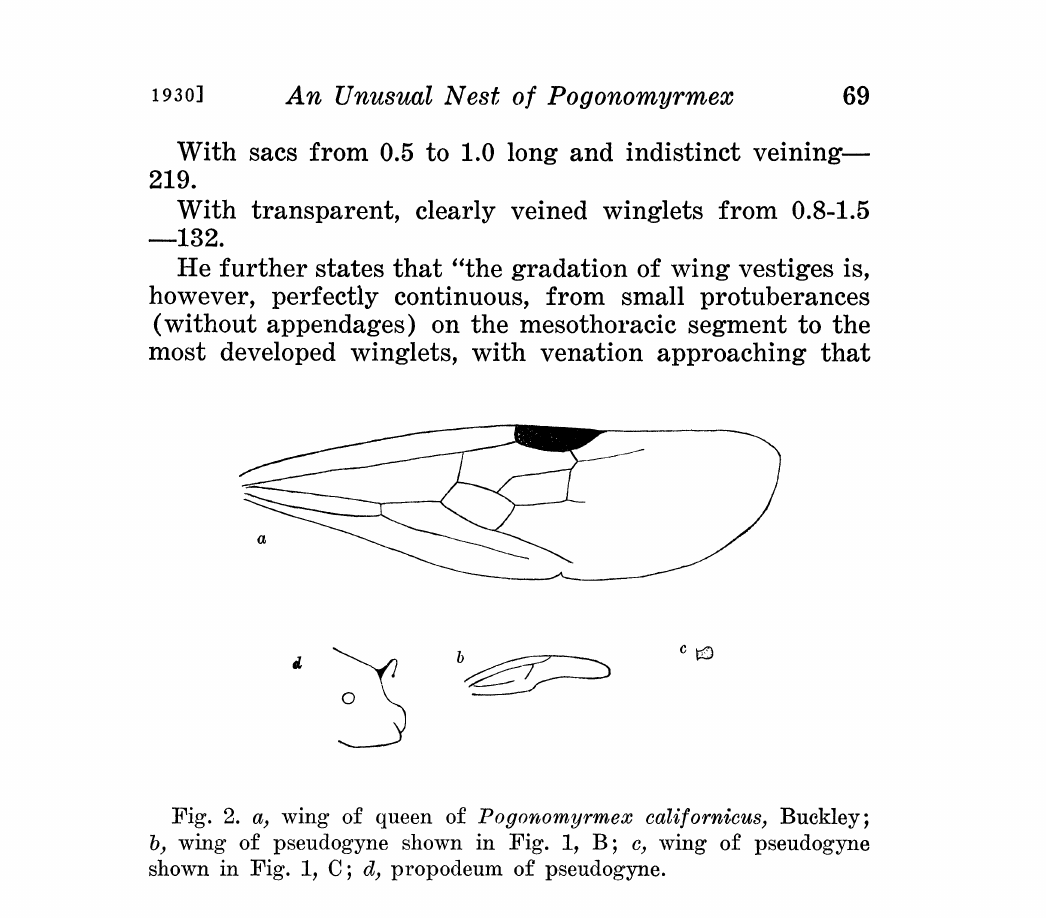
:Fig. 2. a, wing of queen of Pogonomyrmex californicus, Buckley; b, wing of pseudogyne shown in Fig. 1, B; c, wing of pseudogyne shown in :Fig. 1, C; d, propodeum of